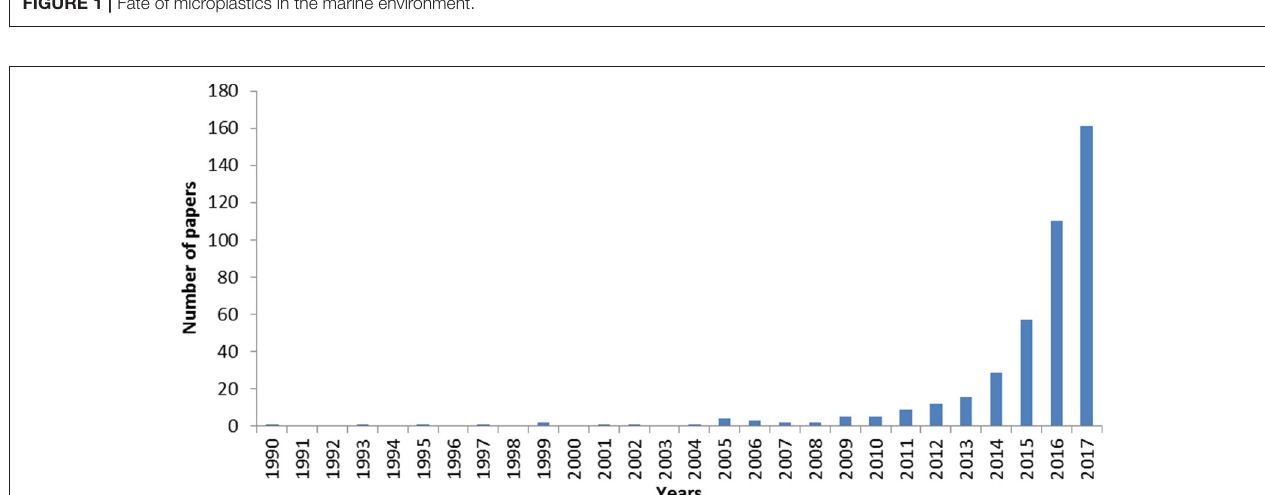
FIGURE 2 | Number of published scientific papers related to the assessment of the microplastic effects on aquatic organisms through lab experiments over time. Source: Web of Science; Period: 1975-2017; Keywords: (microplastic* OR “micro-plastic*” OR nanoplastic* OR “nano-plastic*” OR “plastic particle*) AND (impact* OR exposure OR experimental OR lab* OR tank) AND (ocean* OR sea OR seas OR marin* OR seawater* OR water OR